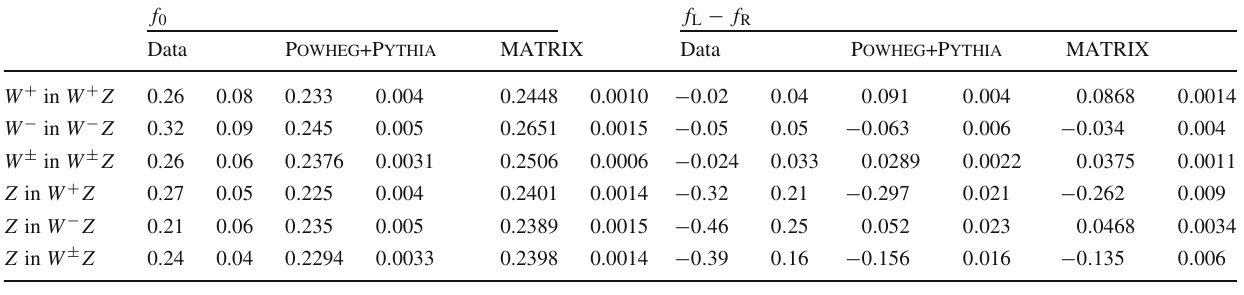
Table 6 Summary of the absolute uncertainties in the helicity fractions f 0 and f L − f R measured in W ± Z events for W and Z bosons